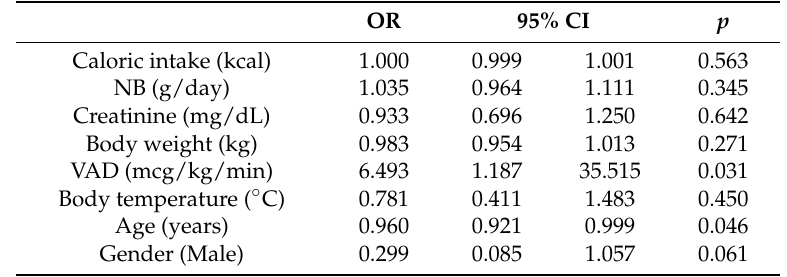
Table 3. Multivariate analysis of variables associated with hypermetabolism in severe AKI patients.